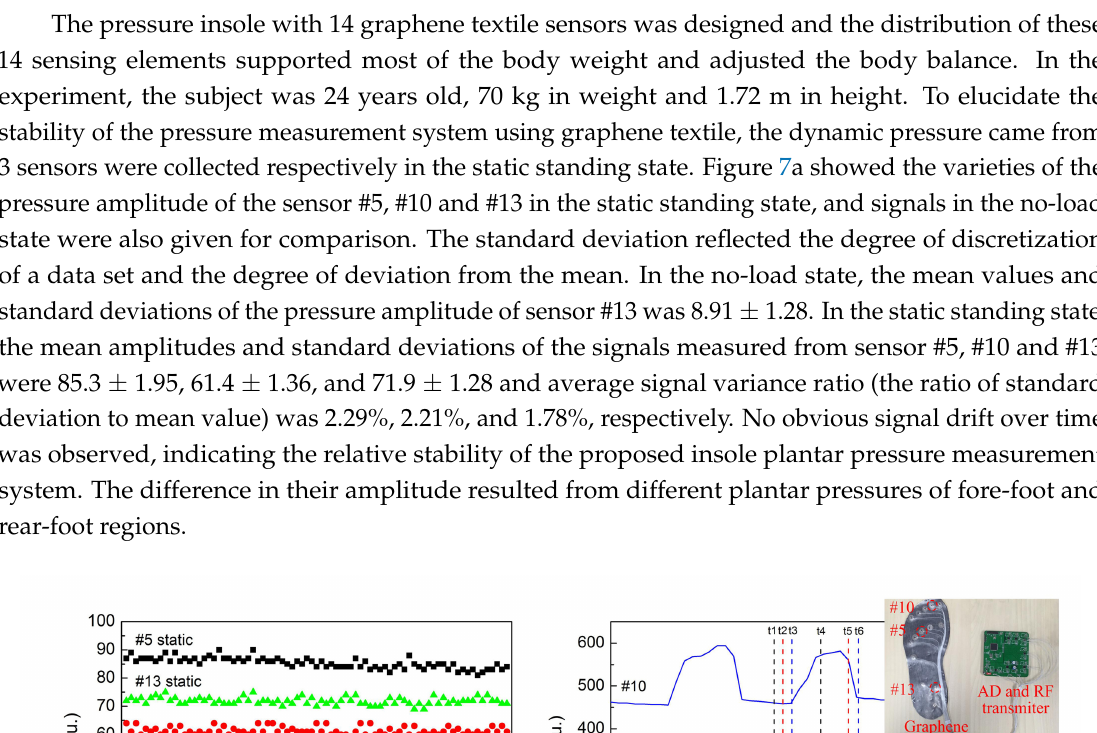
Figure 6. ( a ) Laboratory set-up for the study of the reliability of graphene sensor. ( b ) Repeated measurement of the sensor to evaluate its sensing stability: 120 cycles of 50 kPa applied at 1-s intervals. The insert showed detail of 5 cycles.